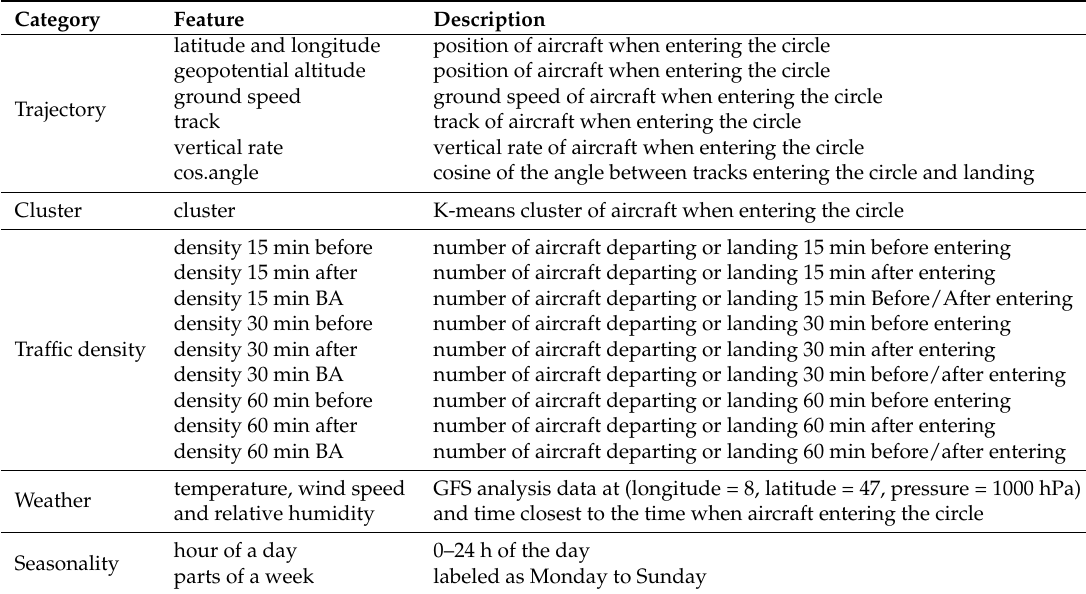
Table 1. Summary of features, relevant for the aircraft landing time prediction. GFS, Global Forecast